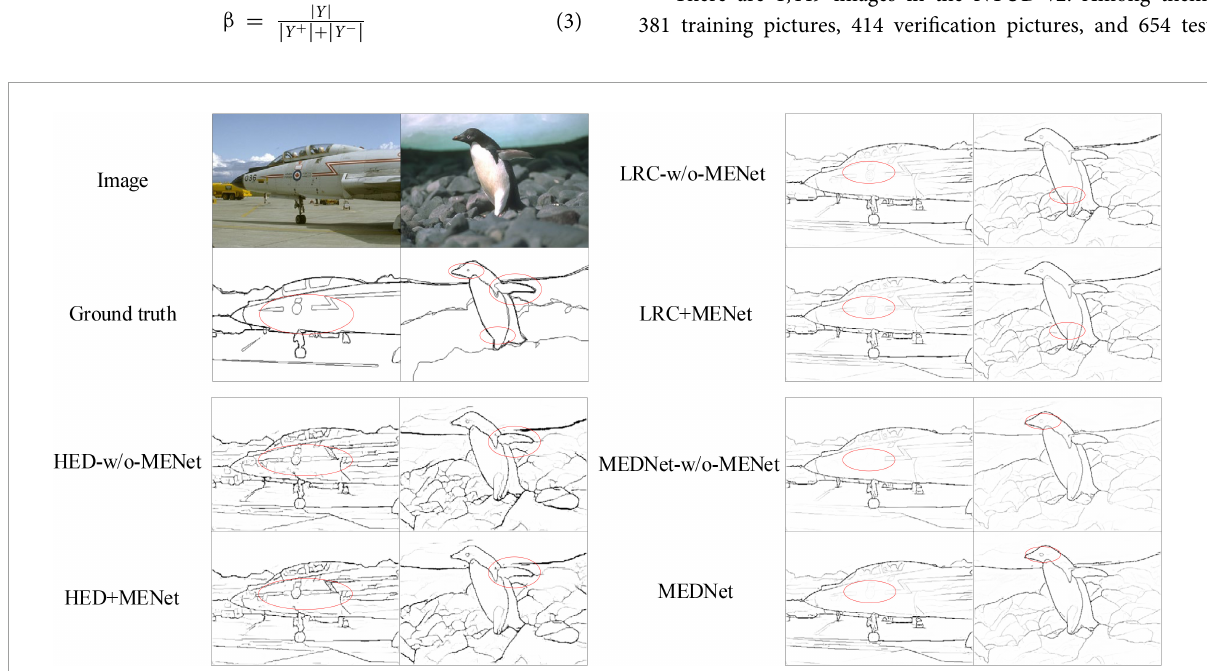
FIGURE7 Schematic plots of the output of Holistically-nested edge detection (HED), Richer convolutional features (RCF), LRC and modulation encoding and decoding network (MEDNet) before and after combining with modulation-enhancement network (MENet). On the left, from top to bottom, are the original image, the ground truth, HED-w/o-MENet and HED + MENet. The right part runs from top to bottom for LRC-w/o-MENet, LRC + MENet, and MEDNet. Source photos: BSDS500 dataset - publicly available